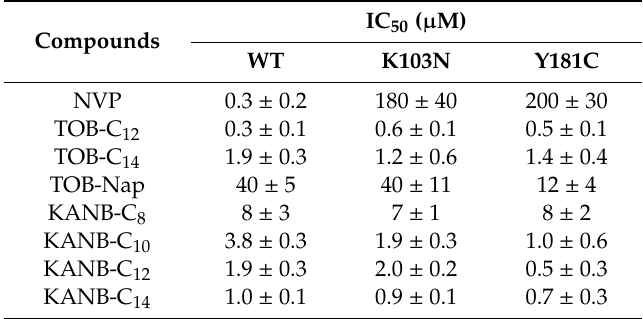
Data represent the mean ± SEM from 3 or more independent